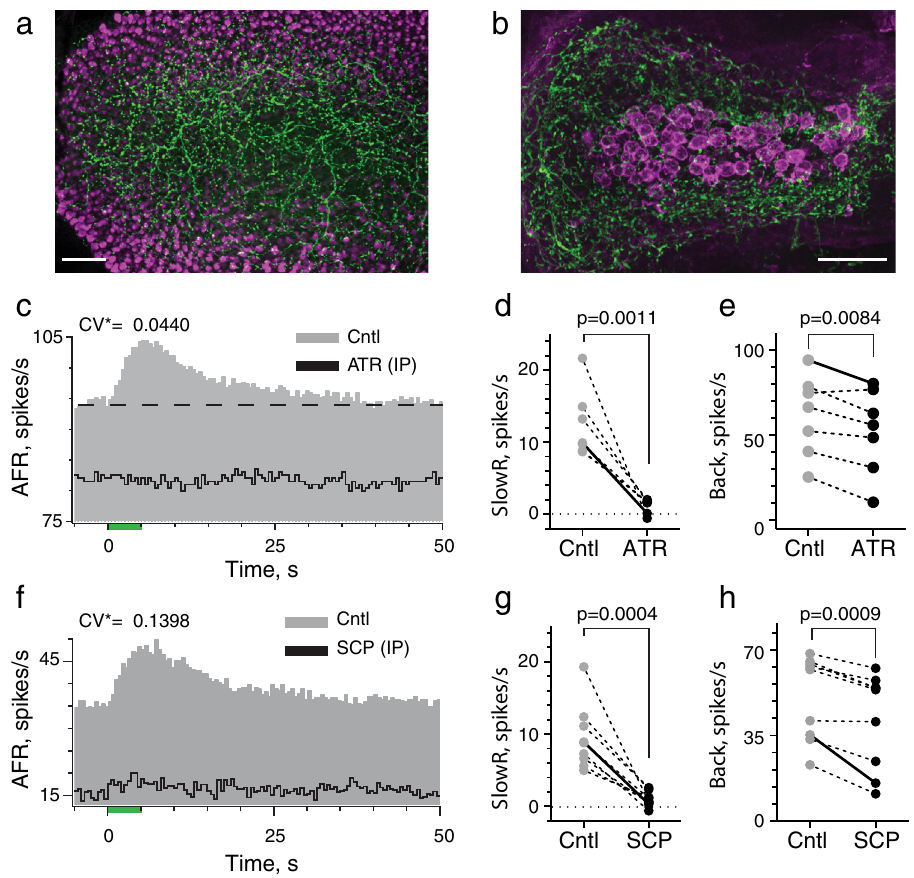
Figure 5. The muscarinic ACh receptor antagonists, atropine and scopolamine, block efferent-mediated slow excitation in mouse vestibular afferents. ( a,b ) Whole-mount immunofluorescence of the mouse saccular macula and canal hemicrista (dorsal view) showing that ChAT- positive EVS neurons (green) innervate the full extent of the neuroepithelium. Hair cells ( a ) and calyx afferents ( b ) are counterstained with antibodies against calretinin (magenta). Scale Bars: 50 µm. ( c ) Average response histograms showing the effects of midline efferent stimulation in a regular afferent before (Cntl, gray) and after IP administration of 0.5 mg/kg atropine (ATR, black). Histograms in each condition were tabulated from 7 efferent shock trains. ( d,e ) Mean peak slow excitation (SlowR) and background discharge rates (Back) for seven individual units during control and atropine conditions (EVS stimulation: midline, n = 4; ipsilateral, n = 3). ( f ) Average response histograms showing the effects of midline efferent stimulation in an irregular afferent before (Cntl, gray) and after IP administration of 0.5 mg/kg scopolamine (SCP, black). Histograms for control and SCP conditions were tabulated from 6 and 8 efferent shock trains, respectively. Binning in panels ( c,f) is 500 ms. ( g,h ) Mean peak slow excitation (SlowR) and background discharge rates (Back) for nine individual units during control and scopolamine conditions (EVS stimulation: midline, n = 6; ipsilateral, n = 3). Example histograms shown in panel ( c,f) appear as solid lines in panels ( d , e,g , h) , respectively. In population data from both atropine ( d,e ) and scopolamine ( g,h ), the range and mean doses were 0.2–2 mg/kg and 0.75 mg/kg, respectively. Indicated p values from comparisons made using a paired t